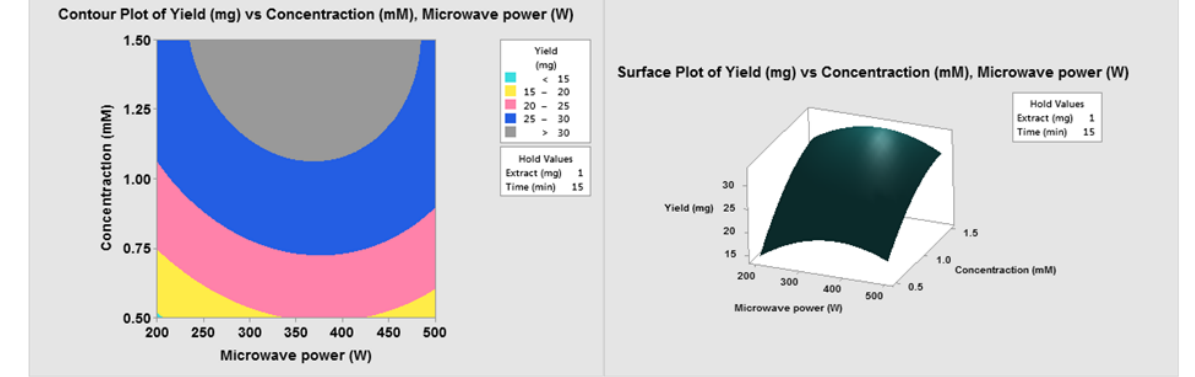
Figure 3. Microwave power and total metal concentration effect on NP yield.